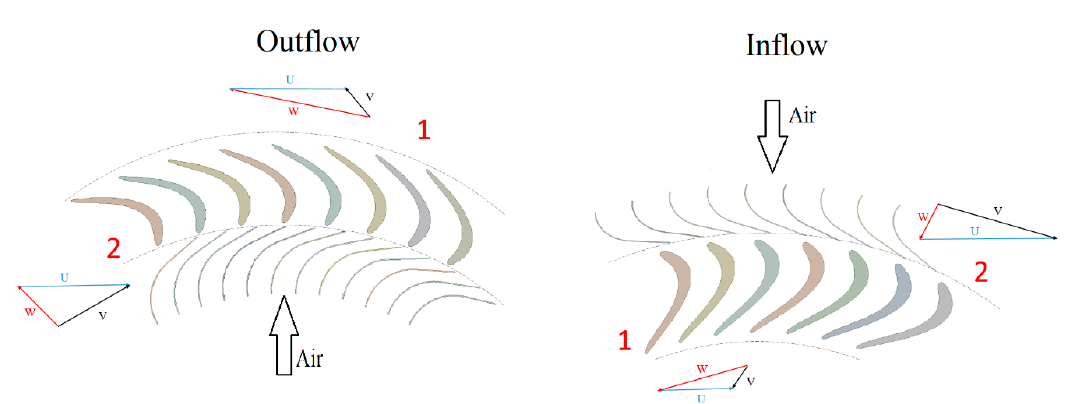
Figure 17. Schematics of the airflow velocity components at the rotor section of the outflow and inflow turbines.